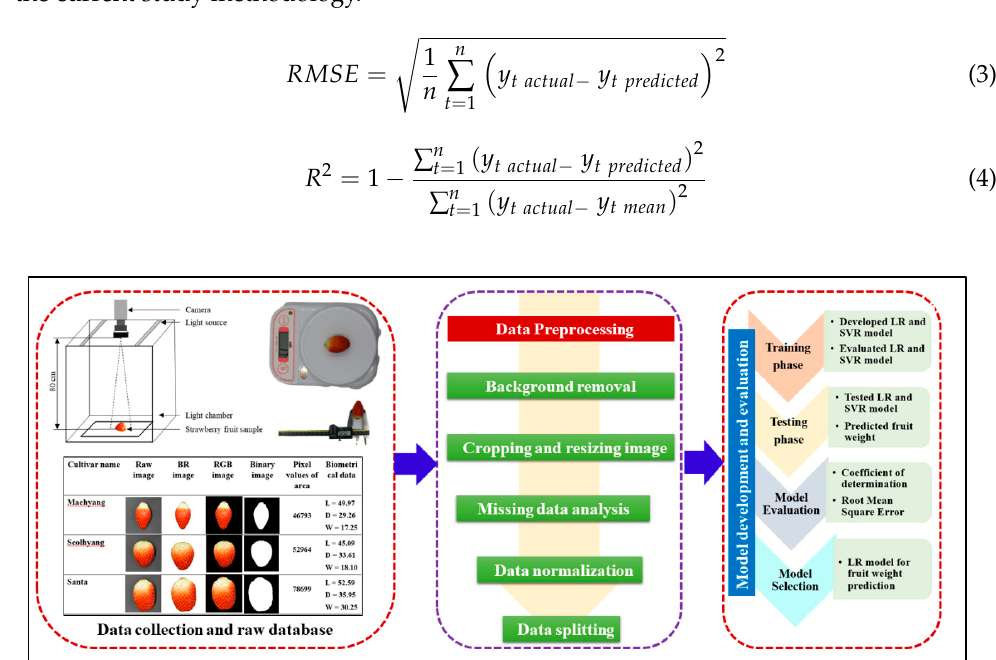
Figure 5. Flow diagram of prediction of fruit weight of strawberries with pixel values using linear regression (LR) and support vector regression (SVR) algorthims.